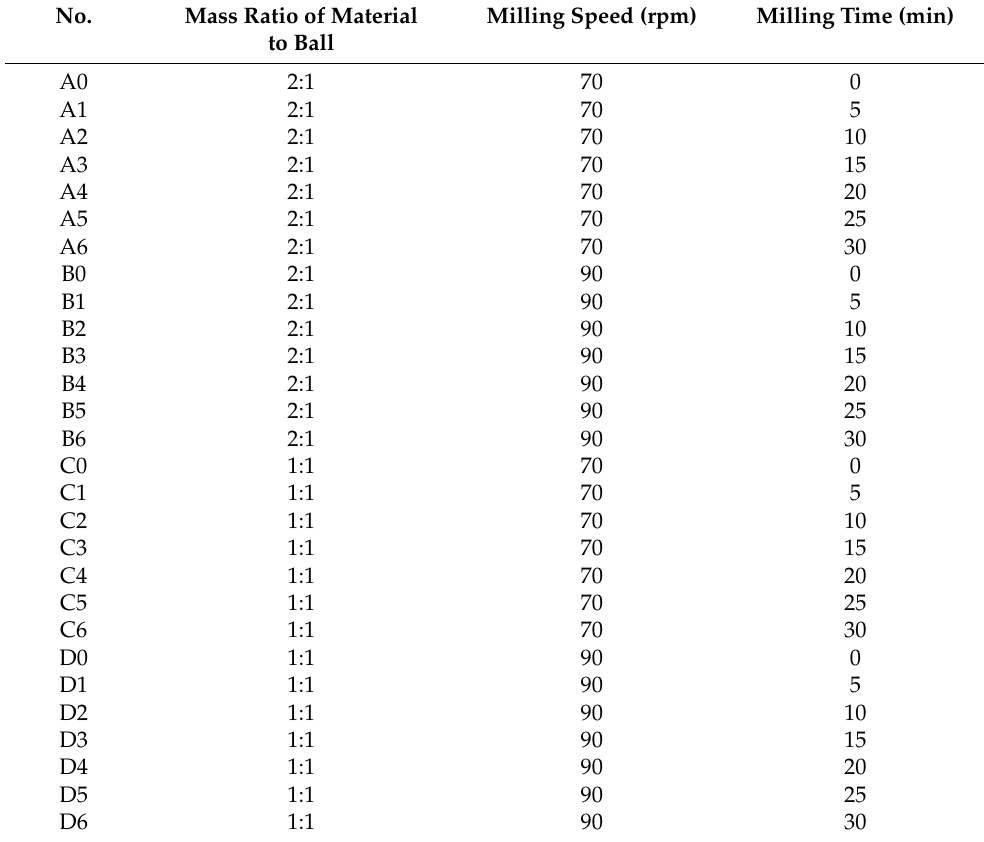
Table 2. Ball-milling test